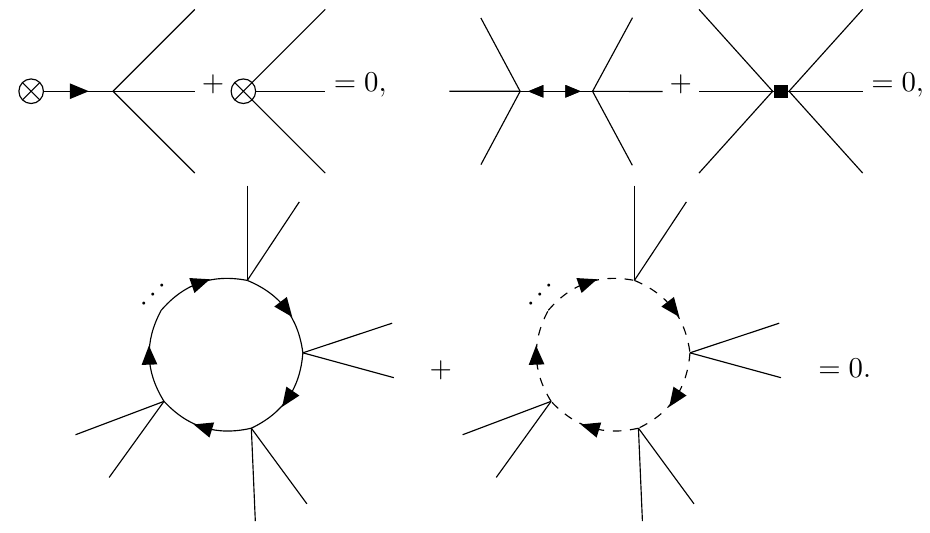
Figure 2 . Cancellations between